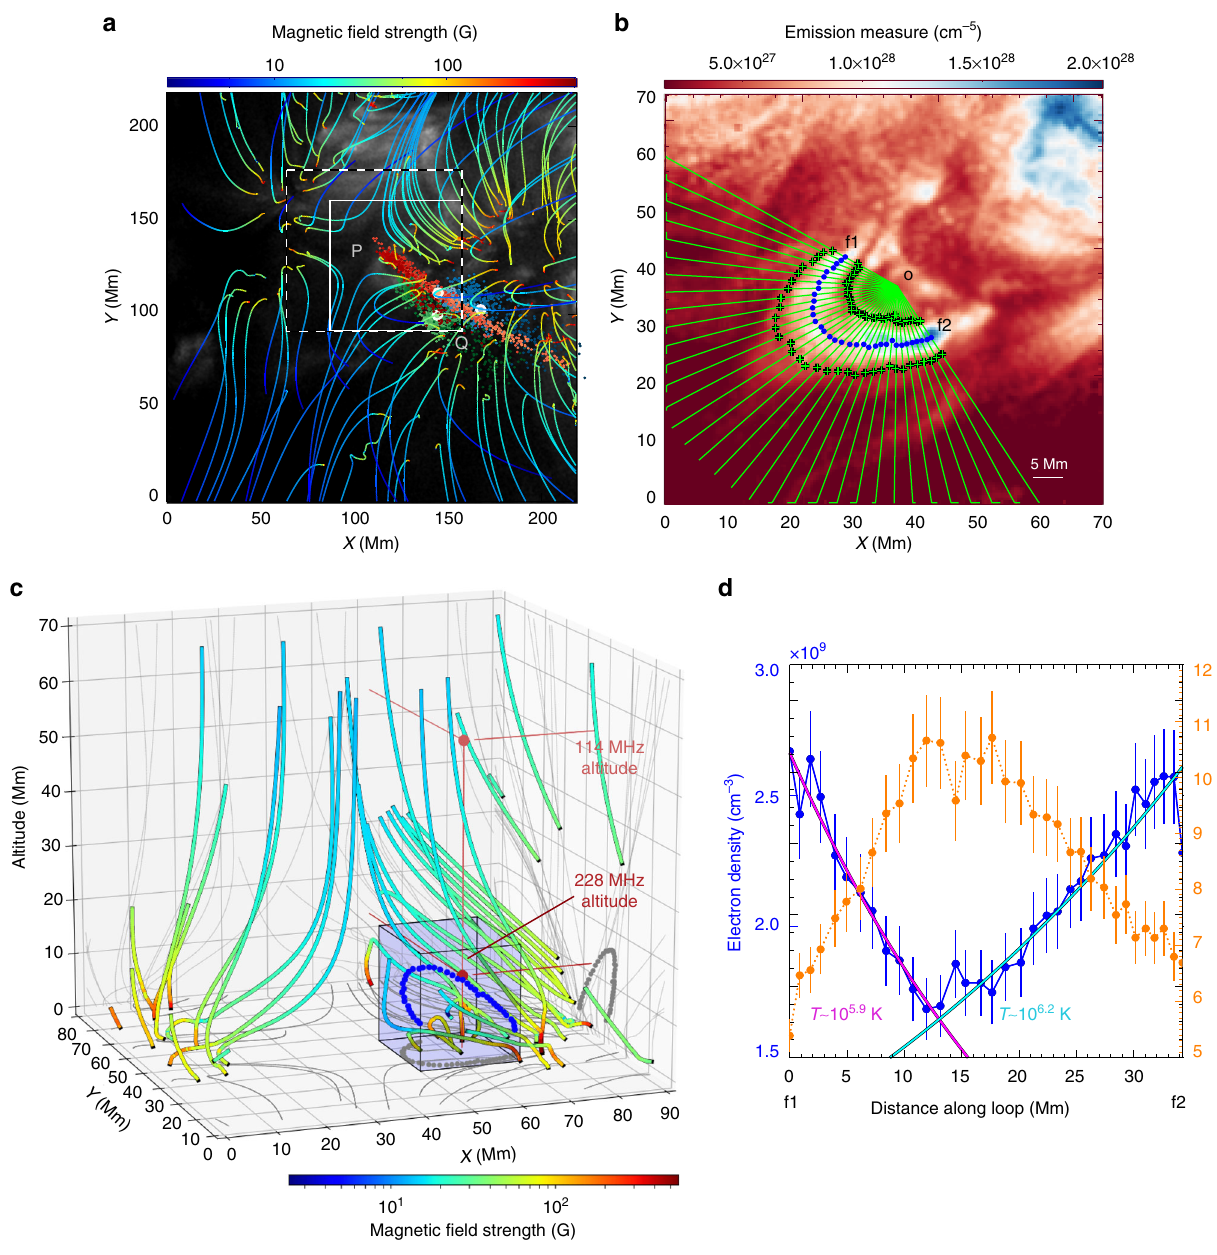
Fig. 5 Magnetic fi eld and density environment of the pulsation origin. a NLFFF extrapolation on AIA 33.5 nm, with the 228, 298 and 327 MHz source maxima throughout the event in red, green and blue points, respectively. b Emission measure map of a zoom of the null point centre (white box in panel a), where we identify a small loop. The width of the loop (distance between inner and outer green points for each radial trace starting at point o) is calculated from f1 to f2. c 3D environment of the NLFFF extrapolation (white dashed box in panel a ), with the 3D position of the small loop indicated by the blue points and the plasma emission heights of 114 and 228 MHz indicated by red points. d Density as a function of distance along the loop (blue circles, with uncertainty of 7%) from f1 to f2. The purple and blue lines are models of a hydrostatic equilibrium with temperature of 10 5.9 K and 10 6.2 K, respectively. The orange data points indicate the loop width as a function of distance along the loop (with uncertainty of 10%). Using the NLFFF magnetic fi eld strength and the density estimate from the EM map, the loop in panel b is capable of sustaining sausage mode oscillation period of P ≤ 1.3 – 1.6